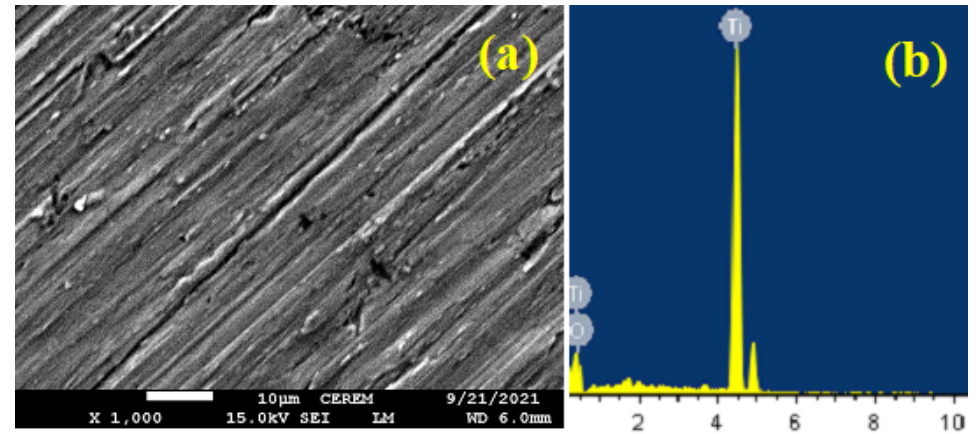
Figure 10. ( a ) SEM and ( b ) EDX analyses for Ti that was immersed for 72 h in SBF before applying 400 mV (Ag/AgCl) for 1